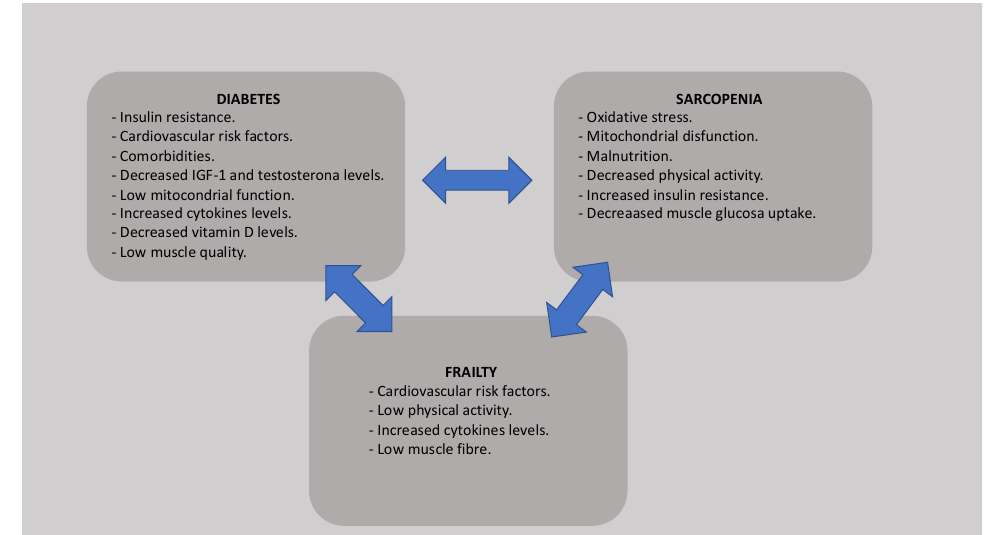
Figure 1. Pathophysiological link between diabetes, frailty, and sarcopenia. Table 1. Fried’s Frailty Criteria. Findings Involuntary weigh loss of 10 lbs or more in the last six